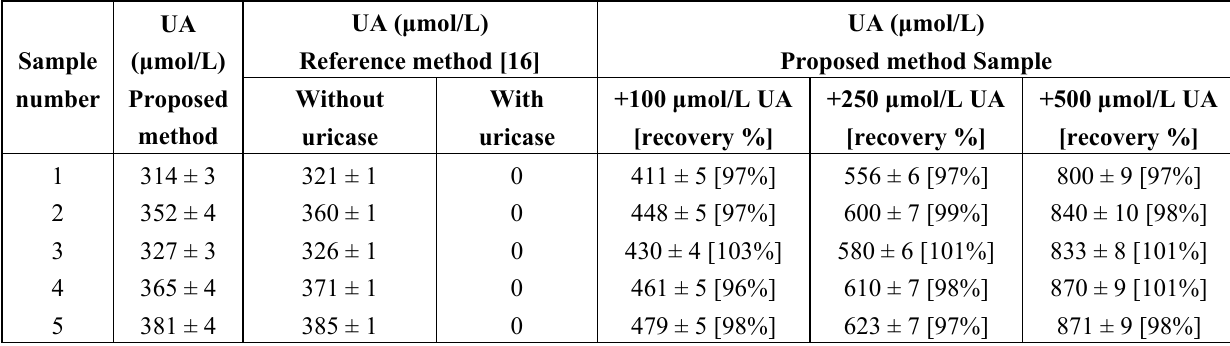
Table 1. Original data used for testing the proposed method for determination of plasma uric acid (UA)-calculated as the difference between TAC and TAC-UA. All data are expressed as means ± SD. All measurements for each sample were done in five